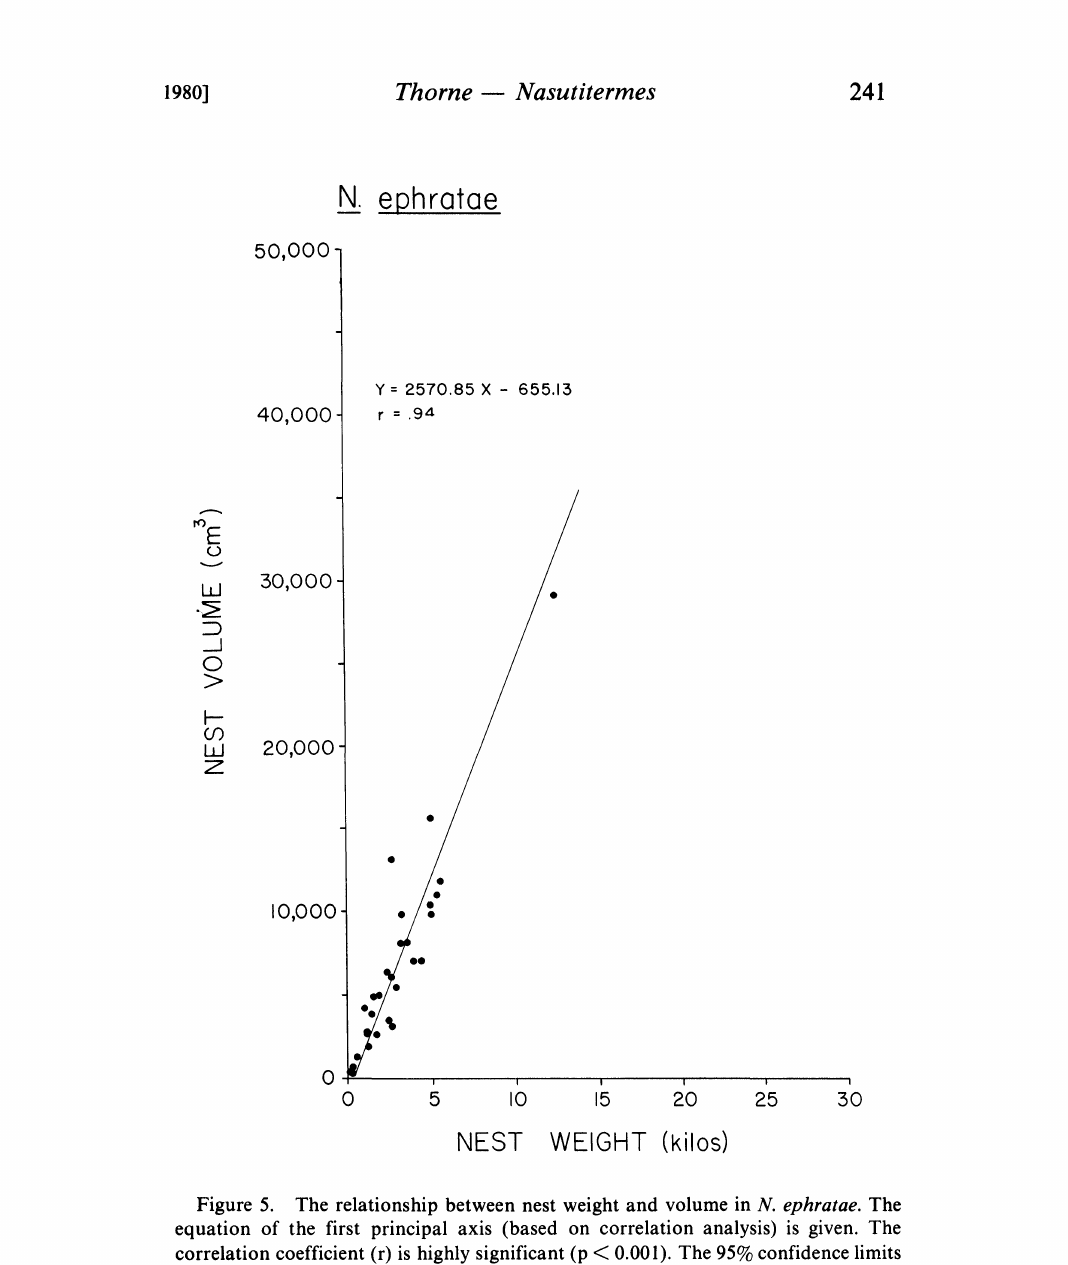
Figure 5. The relationship between nest weight and volume in N. ephratae. The equation of the first principal axis (based on correlation analysis) is given. The correlation coefficient (r) is highly significant (p < 0.001). The 95% confidence limits on the slope of the principal axis are